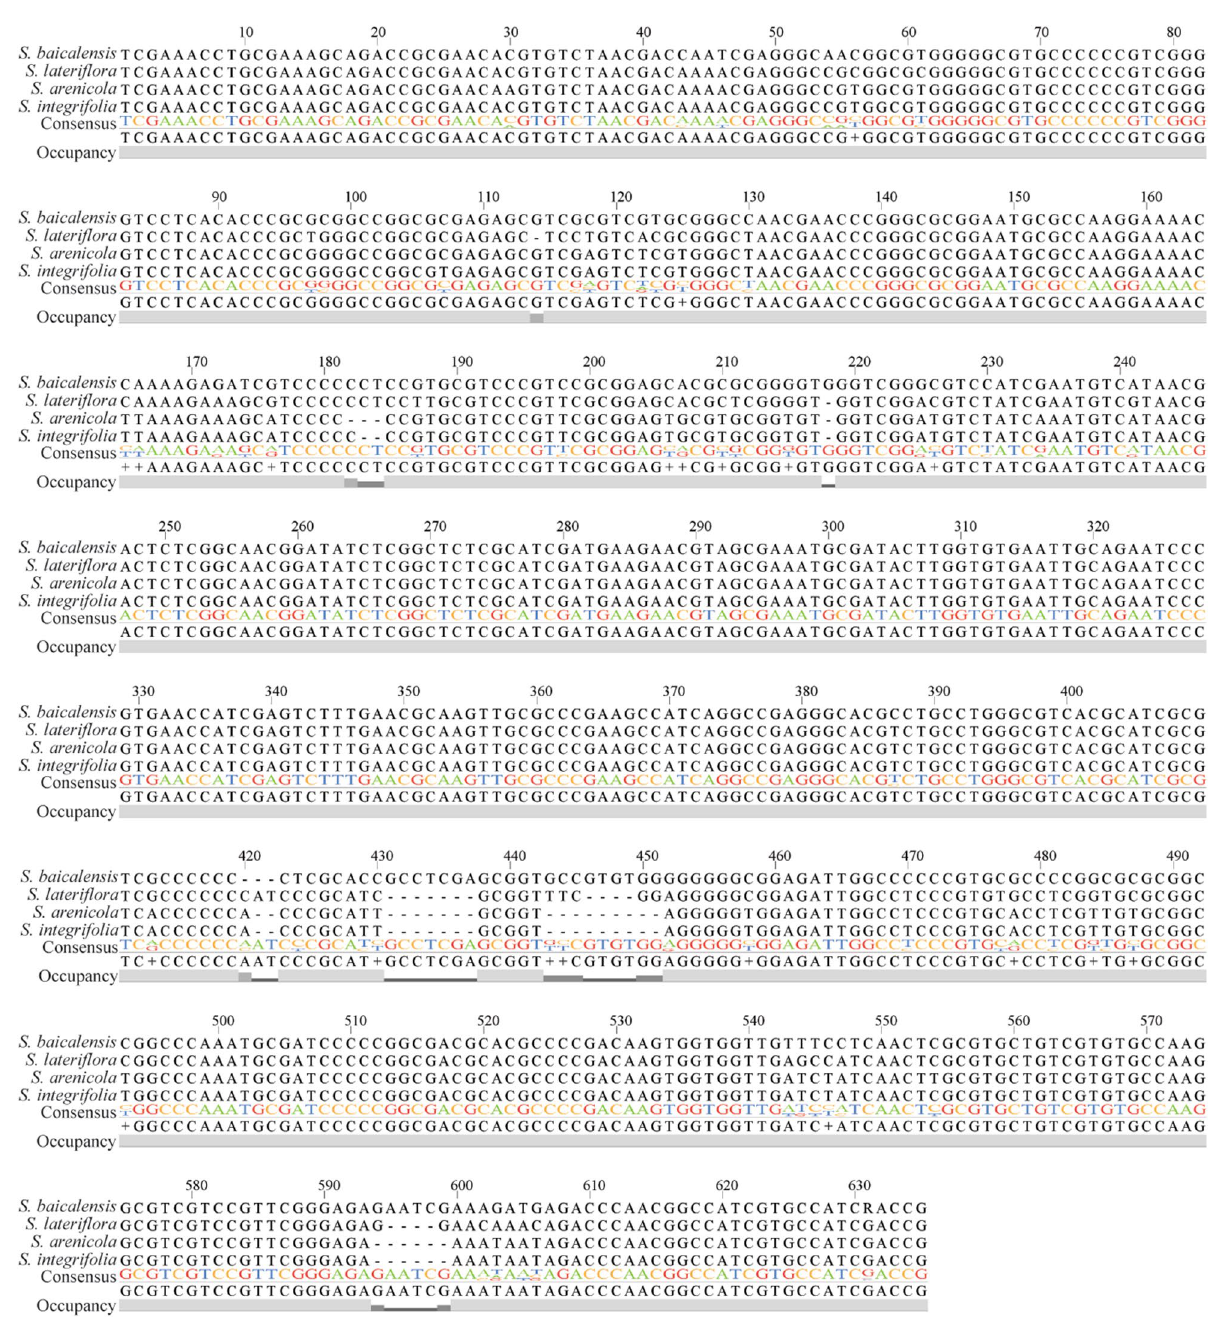
Figure 2. DNA barcoding using ribosomal internal transcribed spacer ( ITS ) marker. The polymorphisms identified in the ITS sequence between Scutellaria baicalensis, S. lateriflora, S. arenicola, and S. integrifolia are represented in this multiple sequence alignment that may be used for species